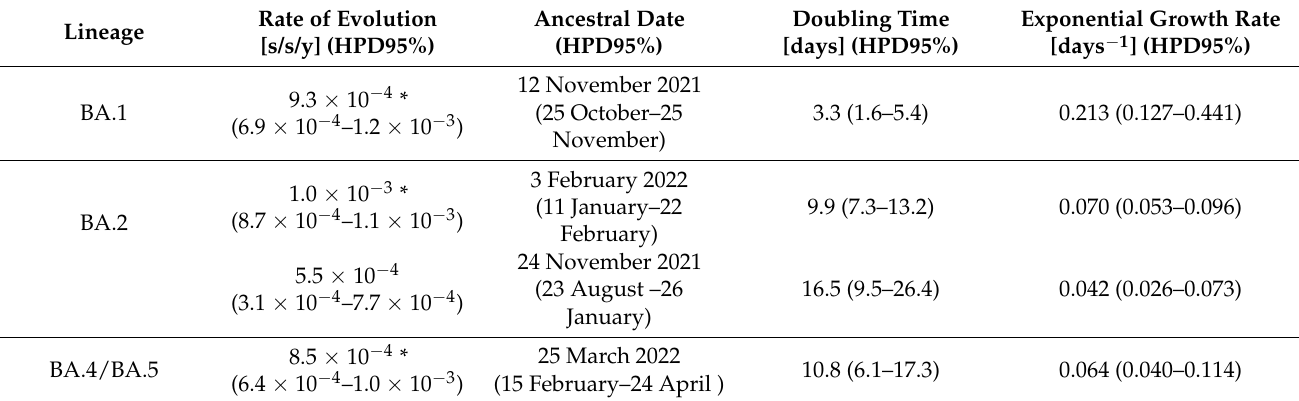
Table 1. Population dynamic parameters estimated from Bayesian coalescent analyses 1